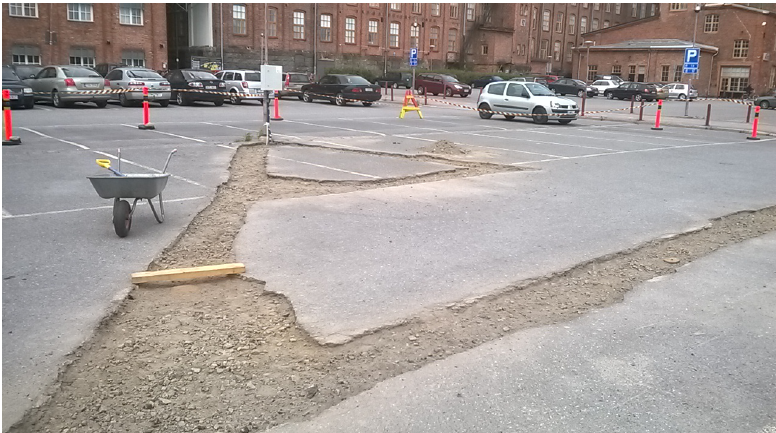
Figure 3. Heat flux data collection site, “Hukseflux,” under the plank.